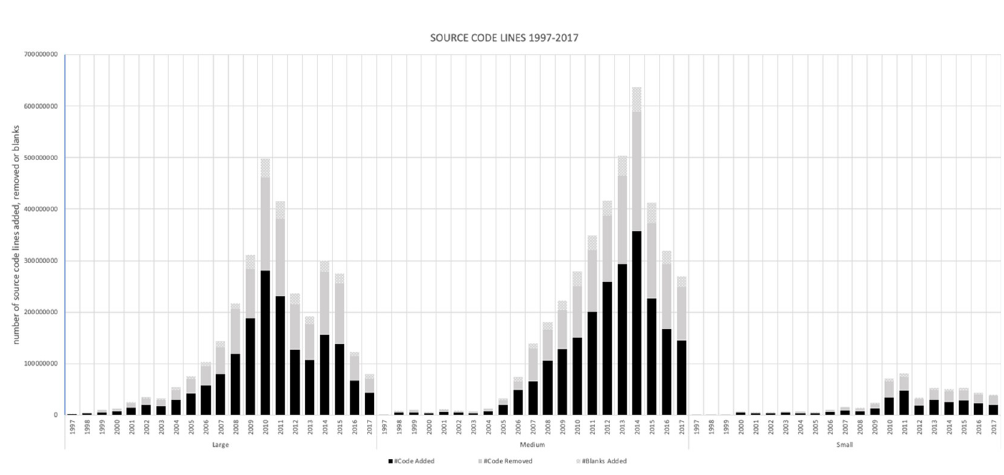
Fig 3. Source code committed in number of lines.